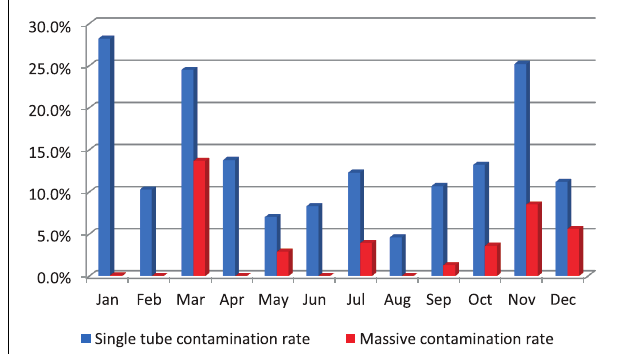
FIGURE 2 | Culture contamination rate,